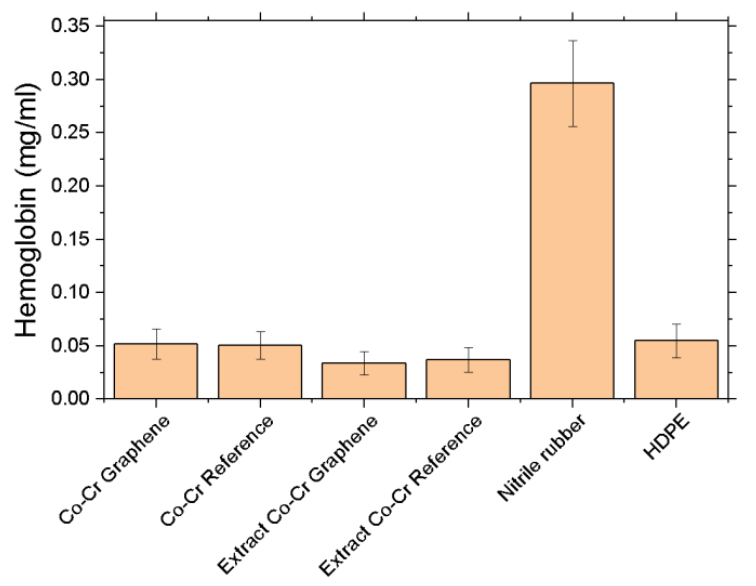
Figure 16. Hemoglobin level after incubation with test materials and extracts from Co-Cr